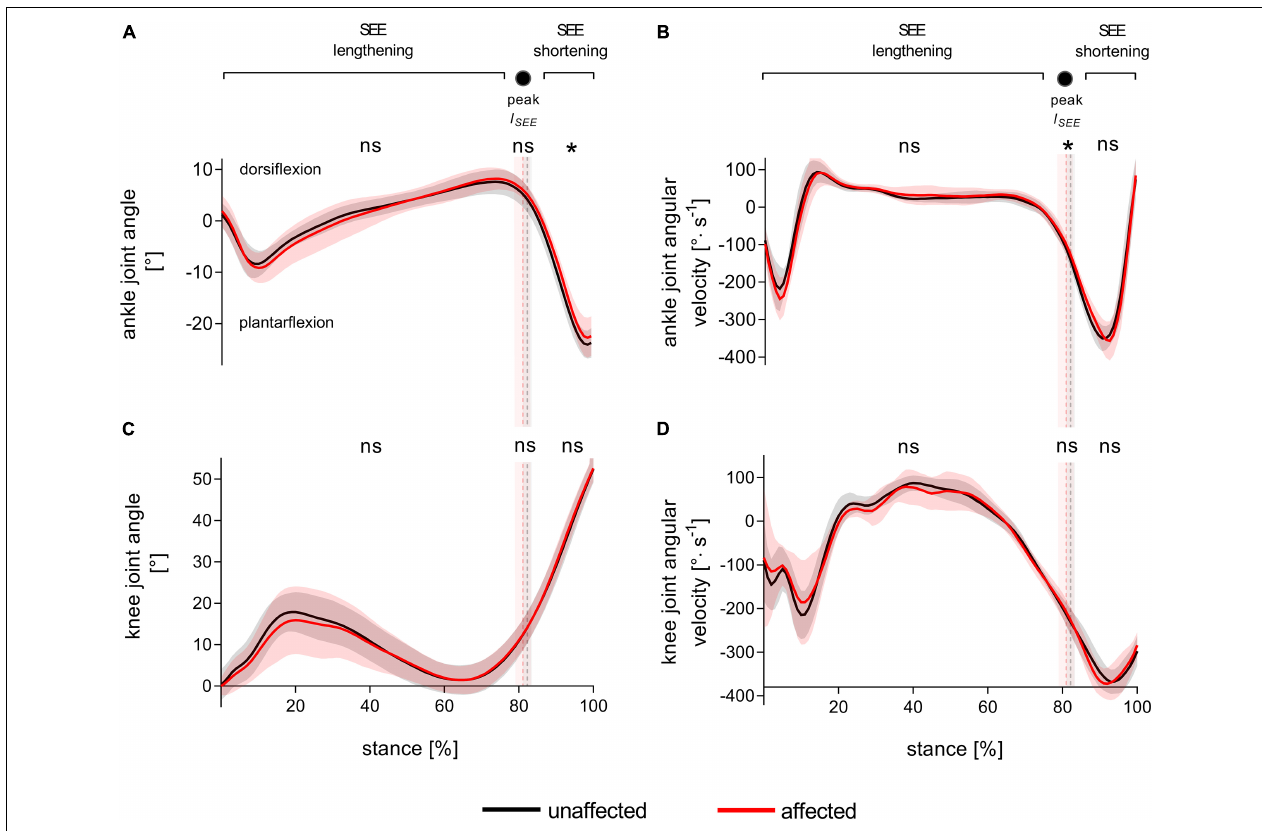
FIGURE 2 | Ankle (A) and knee (C) joint angles and corresponding angular velocities (B,D) during walking stance. The solid black and red lines, with their corresponding shaded areas [standard deviation (SD)], represent mean traces for the unaffected and affected leg, respectively. The dashed vertical lines with their corresponding shaded areas (SD) represent the mean time points of peak series elastic element (SEE) length (peak l SEE ) separating the SEE lengthening and shortening sub-phases. Statistical testing was run on average values during the SEE lengthening and shortening sub-phases, and on single data points at peak SEE length. * p < 0.05, significant side-to-side difference, ns: non-significant.